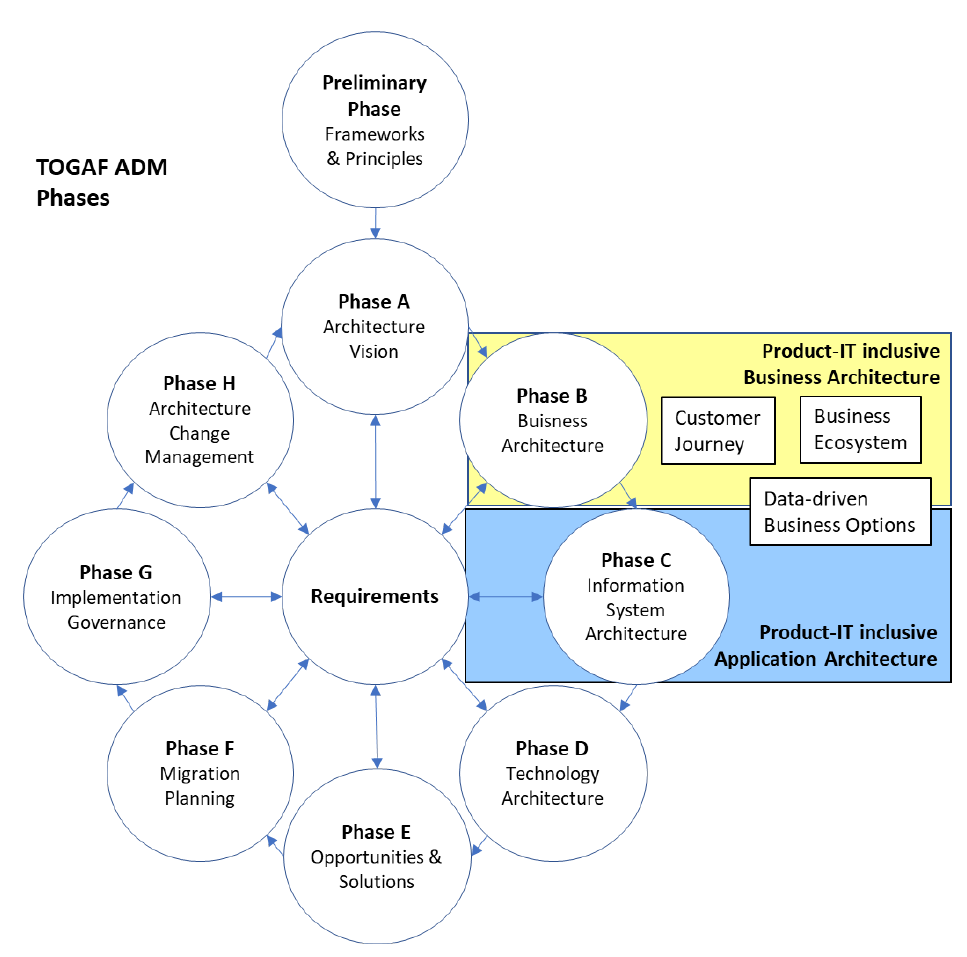
Figure 2. Focal areas and their relation to TOGAF